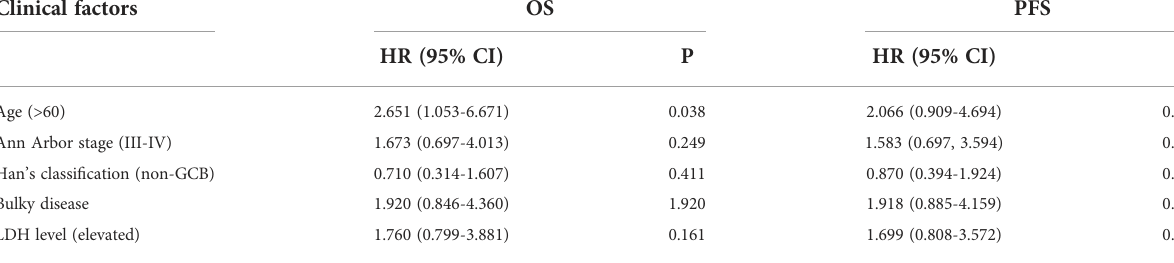
TABLE 3 Univariate Cox analysis of the in fl uencing factors of PFS and OS in the training set. Clinical factors